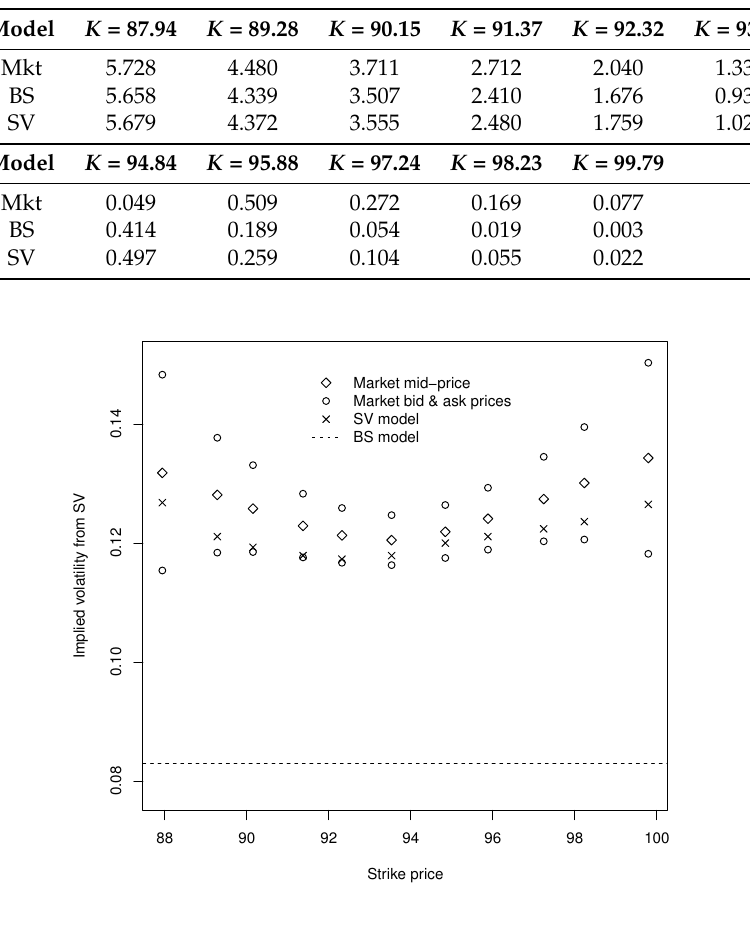
Figure 2. Comparison of volatility smile on the YEN–USD FX rate from the Black-Scholes (BS) model, VG - t SV model, and the